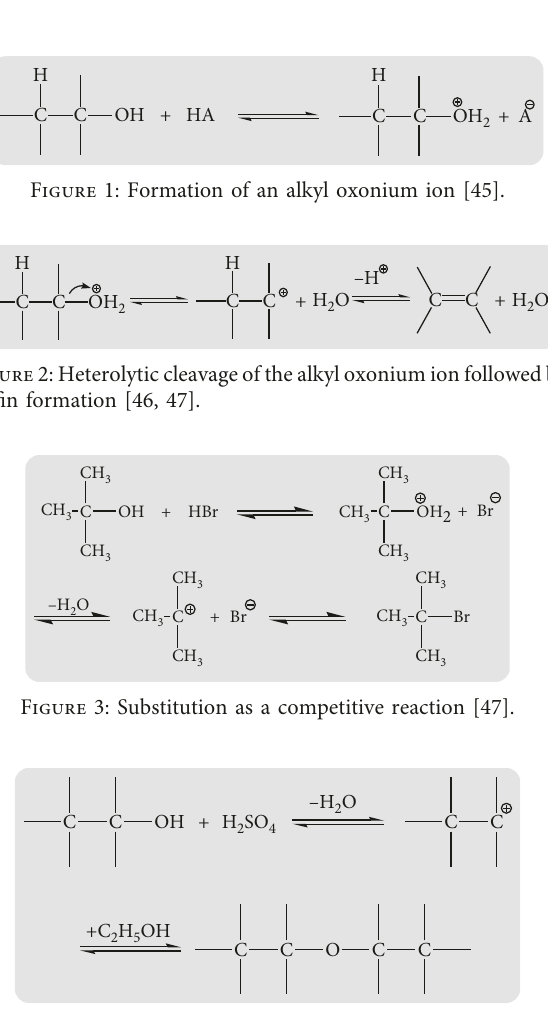
Figure 4: Ether formation as a competing reaction to olefin for- mation [50, 51].